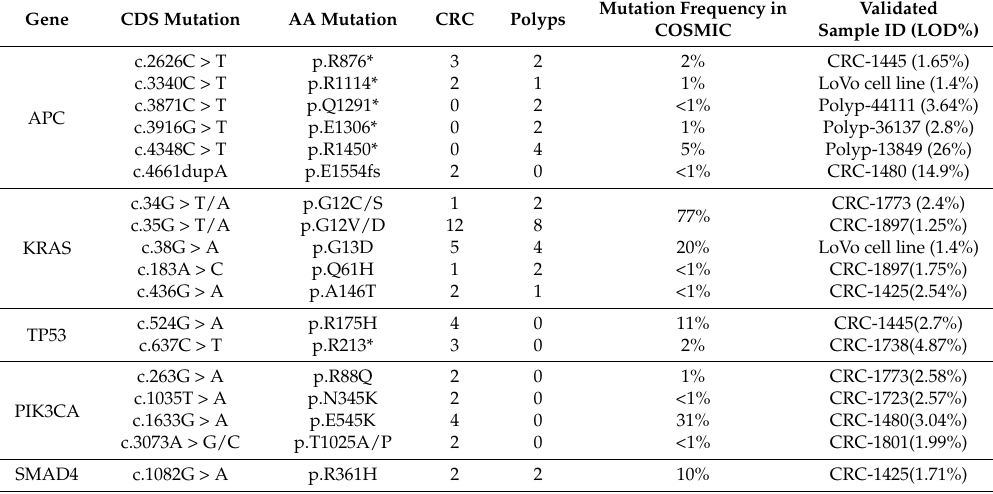
Table 1. Contents of the CGMH CRC stool DNA panel (21 variants in 5 genes).